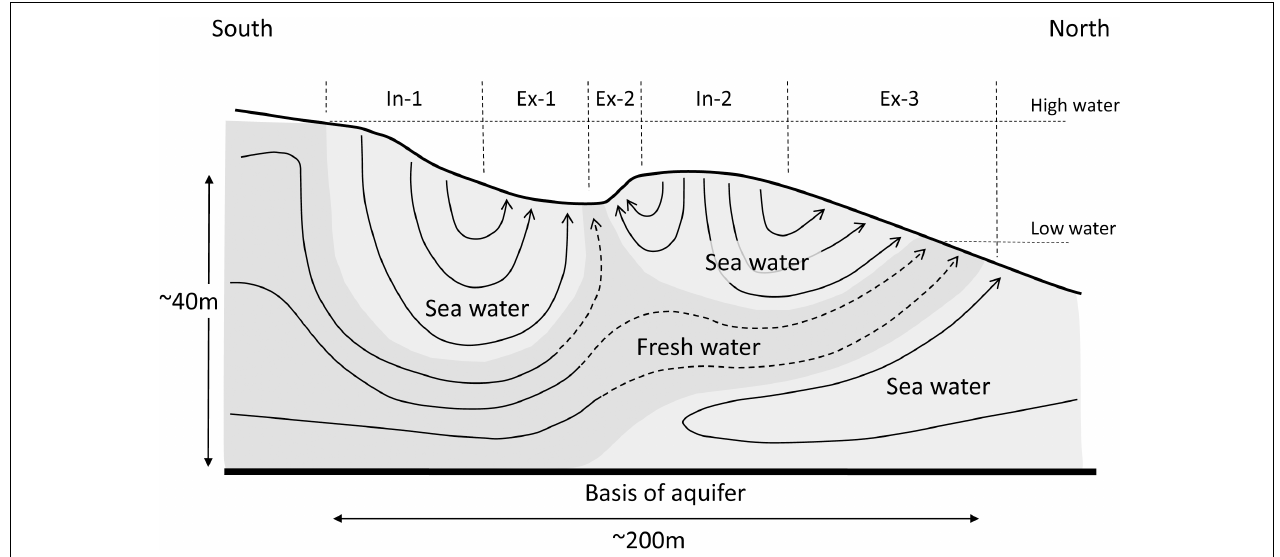
FIGURE 5 | Conceptual model of principal cross-sectional groundwater flow field and location of in- and exfiltration areas (In-1 and In-2 indicate infiltration areas 1 and 2, respectively; Ex-1, Ex-2, and Ex-3 indicate exfiltration areas 1, 2, and 3, respectively) in the intertidal zone at the north beach of Spiekeroog.